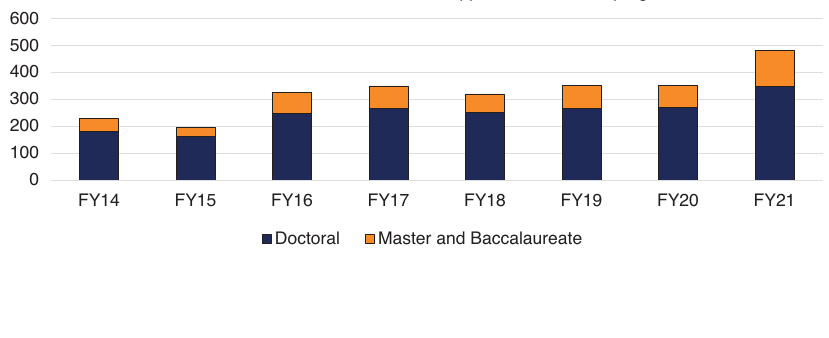
Chart 6: Count of Annual Financial Commitments to Support LYRASIS OA Programs,